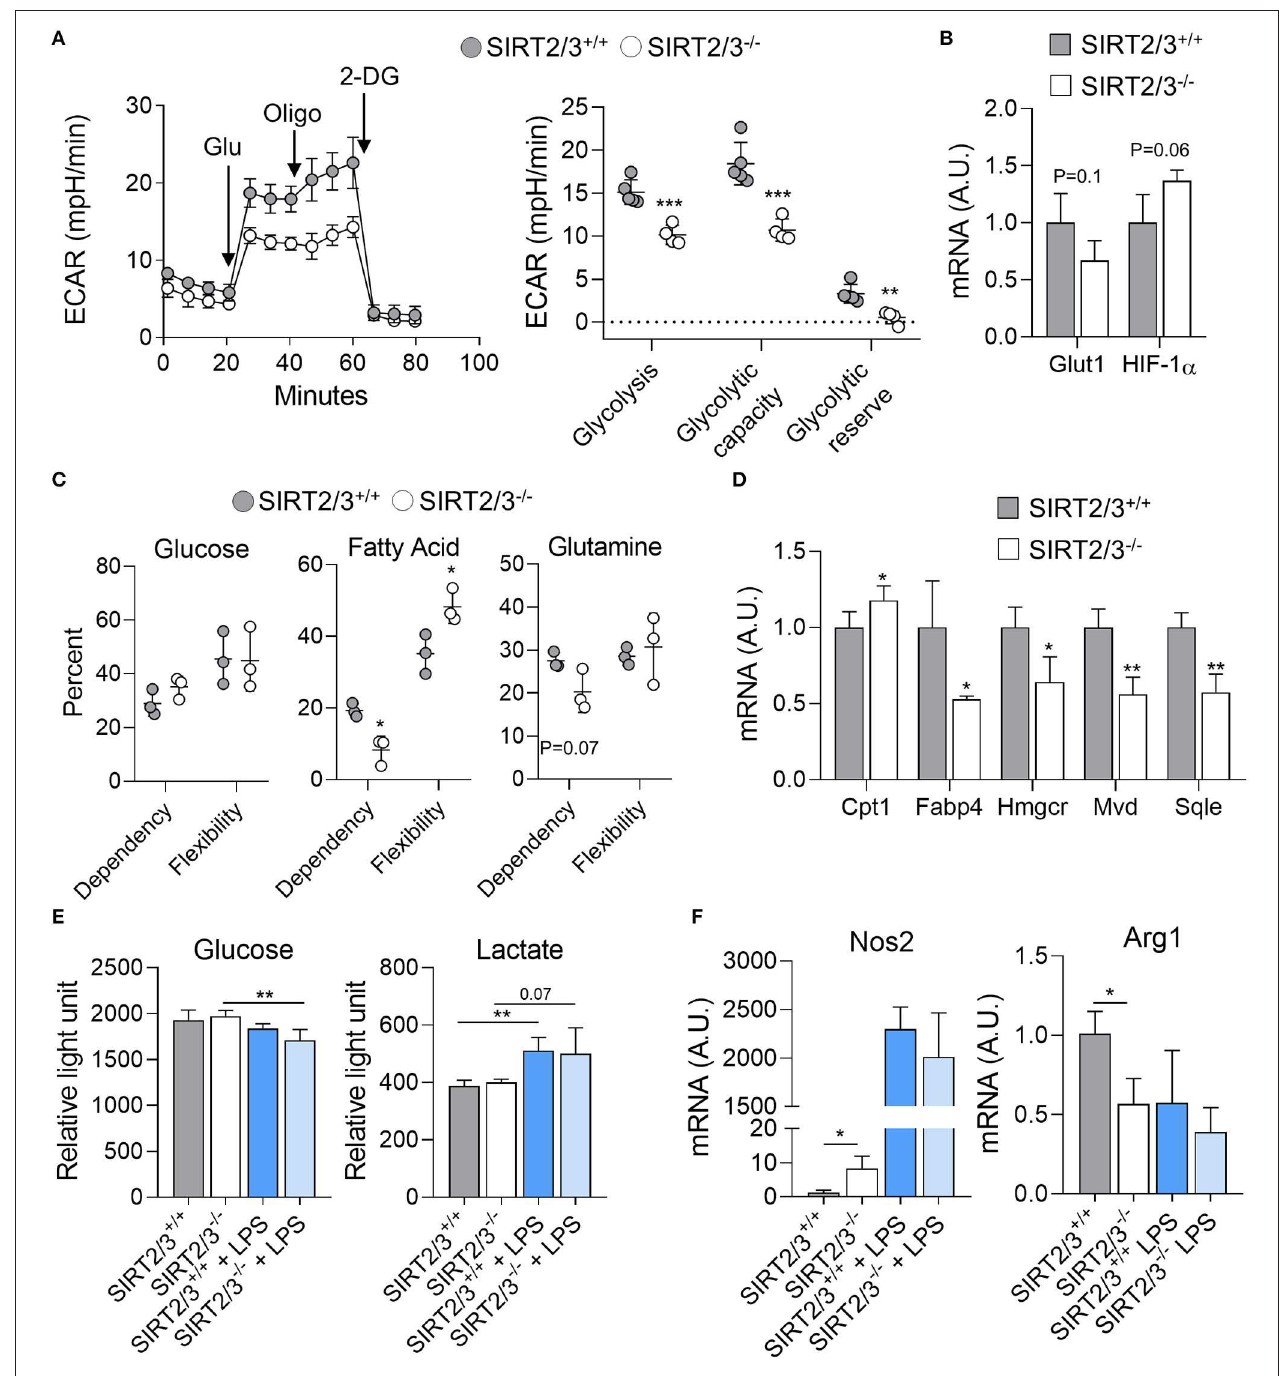
FIGURE 4 | SIRT2/3 deficiency alters macrophage metabolism. (A) The extracellular acidification rate (ECAR) of SIRT2/3 + / + and SIRT2/3 − / − BMDMs was measured using the Seahorse technology (left) and used to calculate the glycolysis, glycolytic capacity and glycolytic reserve (right). Glu, glucose; Oligo, oligomycin; 2-DG, 2-deoxyglucose. (B) Glut1 and Hif1a mRNA levels in BMDMs were quantified by RT-qPCR and normalized to actin mRNA levels. (C) Dependency and flexibility of SIRT2/3 + / + and SIRT2/3 − / − BMDMs toward glucose, fatty acids (FA) and glutamine. (D) Cpt1, Fabp4, Hmgcr, Mvd and Sqle mRNA levels in BMDMs were quantified by RT-qPCR and normalized to actin mRNA levels. (E) Glucose consumption and lactate production by SIRT2/3 + / + and SIRT2/3 − / − BMDMs left unstimulated or stimulated for 8h (glucose) or 24h (lactate) with 10ng/ml LPS. Glucose and lactate were detected using a luminescence-based assay. (F) Nos2 and Arg1 were quantified by RT-qPCR and normalized to actin mRNA levels. Data are means ± SD of 3–5 mice analyzed in triplicate. * P < 0.05; ** P < 0.01; *** P < 0.005.